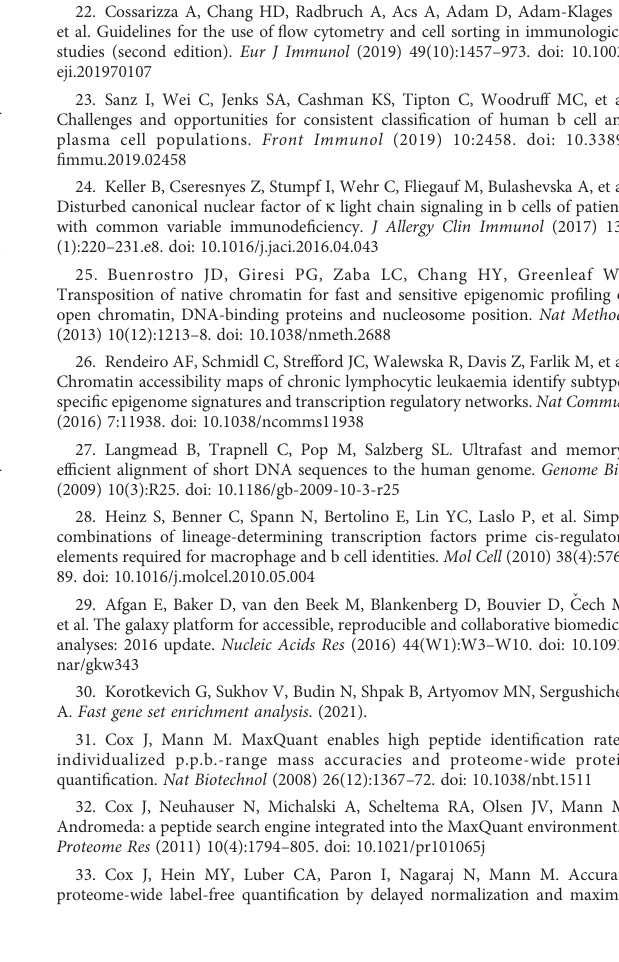
SUPPLEMENTARY FIGURE 3 I k B a expression in unstimulated and stimulated naïve B cells from TACI mutation carriers. (A) Mean fl uorescence intensity (MFI) of I k B a in unstimulated and with CpG, anti-IgM, PMA and CD40L stimulated naïve B cells from affected and unaffected TACI mutation carriers and healthy donor. (B) Ratios of the MFI of I k B a after and without indicated stimulation. P-values (* P <0.05) derive from unpaired t-test calculated with GraphPad Prism 8. # n.s.: non-signi fi cant.